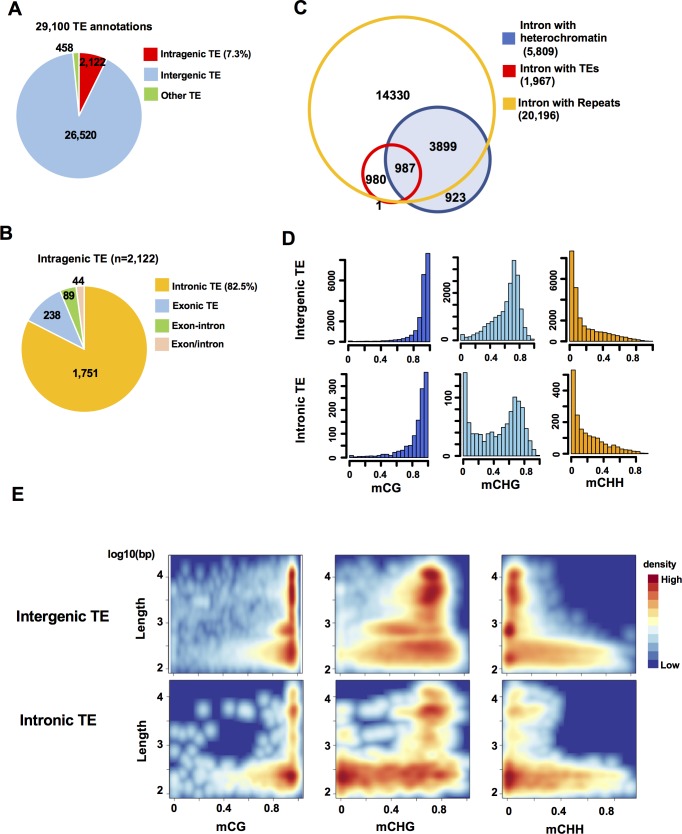
Intronic TEs are short and hypomethylated.(A) Classification of all TEs (n = 29,100) in the rice genome. “Other TEs” refers to TE annotations overlapping to both gene and intergenic regions. (B) Classification of intragenic TEs (n = 2,122) in the rice genome. “Exon-intron” refers to TE annotations overlapping to both exon and intron. “Exon/intron” refers to TE annotations included in an exon of a gene/transcript model as well as in an intron of other gene/transcript models. (C) Venn diagram showing the number of overlapping introns containing heterochromatic domains (blue), TEs (red) and other repeats (yellow). (D) Histograms of the number of intergenic and intronic TEs and their methylation levels (0 to 1) in CG, CHG, and CHH contexts. TEs with methylation data at ≥ 5 Cs were included in the analysis. (E) Density plots showing length (log10) and methylation levels (0 to 1) of intergenic and intronic TEs in CG, CHG, and CHH contexts. TEs with methylation data at ≥ 5 Cs in each context were included in the analysis.